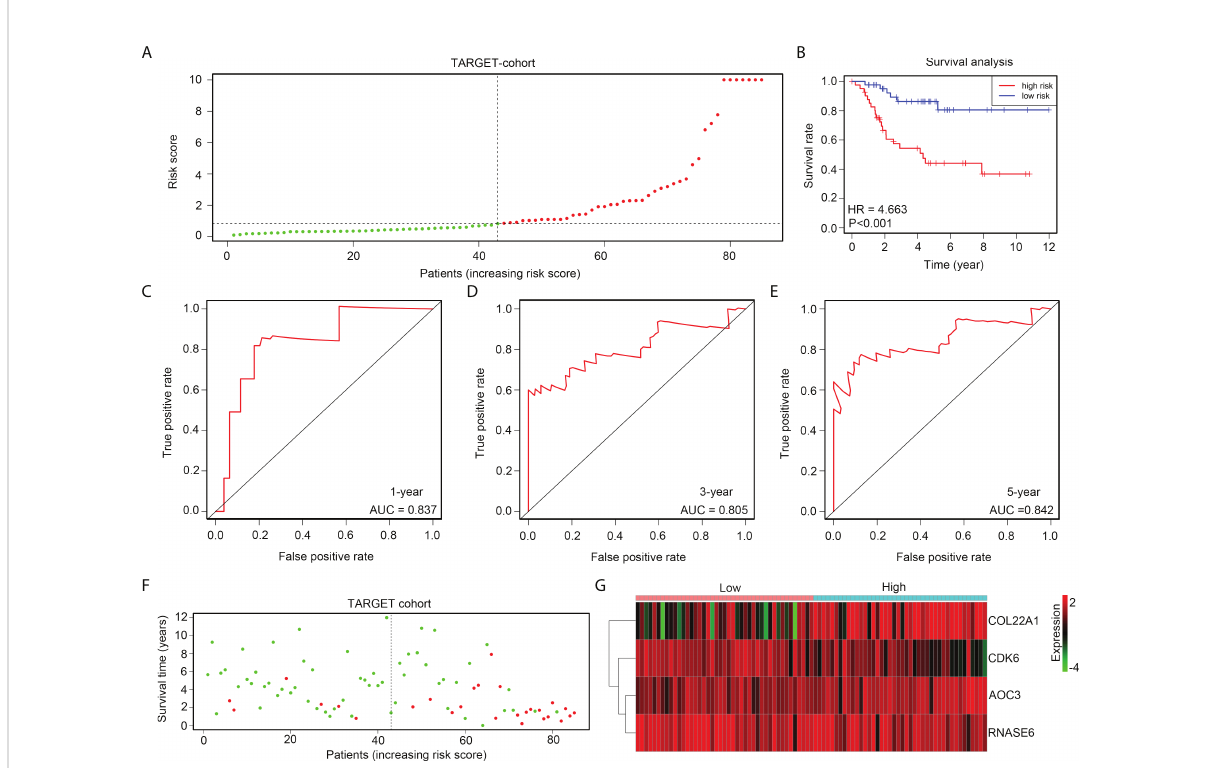
FIGURE 4 The risk model exhibits high prognostic value in the TARGET discovery cohort. (A) OS tissues in TARGET were divided into low- and high-risk groups, according to median risk scores. (B) Kaplan survival analysis indicated the difference between low- and high-risk group OS tissues in TARGET. (C – E) ROC analyses of the risk model for the 1-year, 3-year, and 5-year survival rates for OS patients in TARGET. (F) Alive and death cases between low- and high-risk group OS tissues in TARGET. (G) Expression of COL22A1, CDK6, RNASE6 and AOC3 between low- and high- risk group OS tissues in